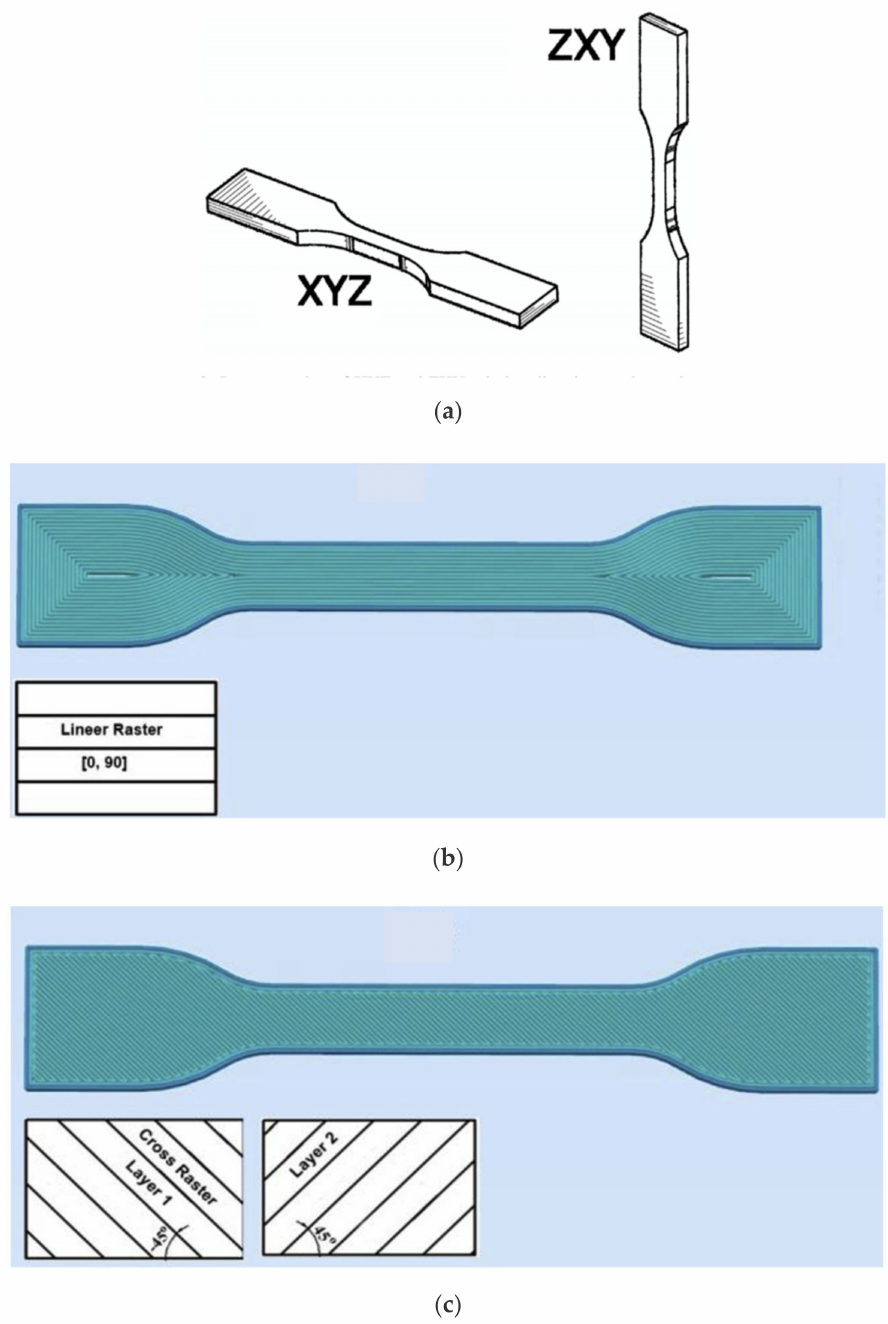
Figure 18. ( a ) XYZ—horizontal orientation; ZXY—vertical orientation (Torrado et al., 2015) [123] ( b ) raster angle of [0, 90]; ( c ) raster angle of [ − 45, 45] (Sezer and Eren, 2019)